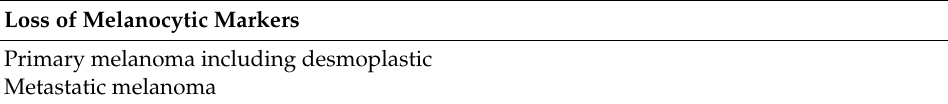
Table 1. Aberrant expression of immunohistochemical markers in malignant